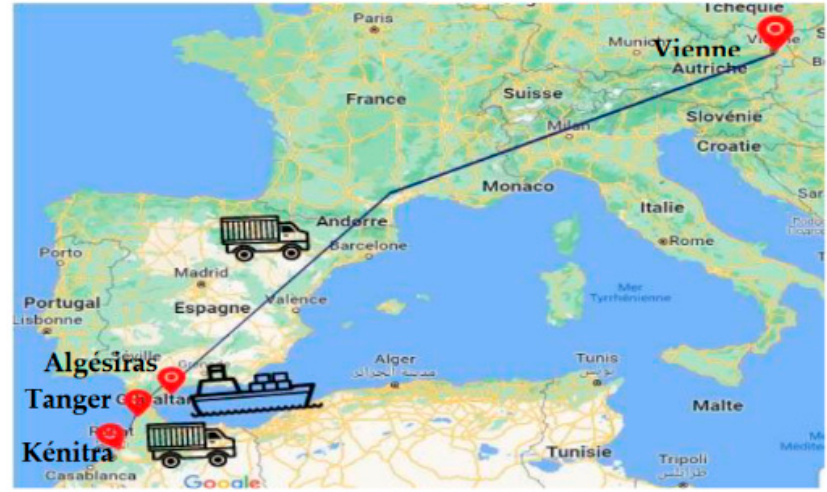
Figure 4. Road and sea transport route.